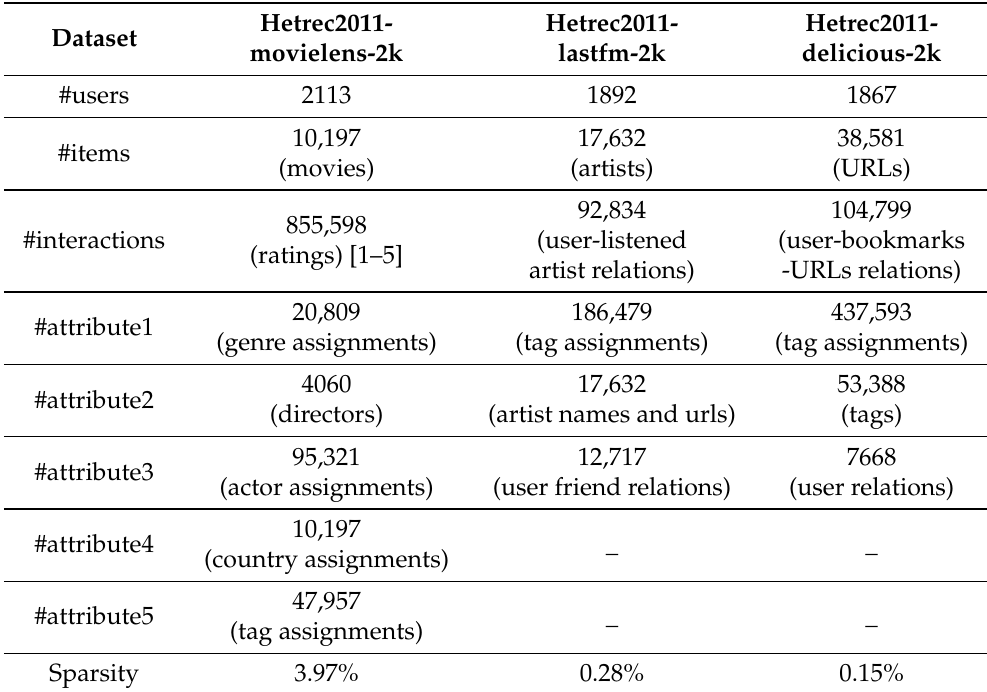
Table 2. Statistics of the pre-processed